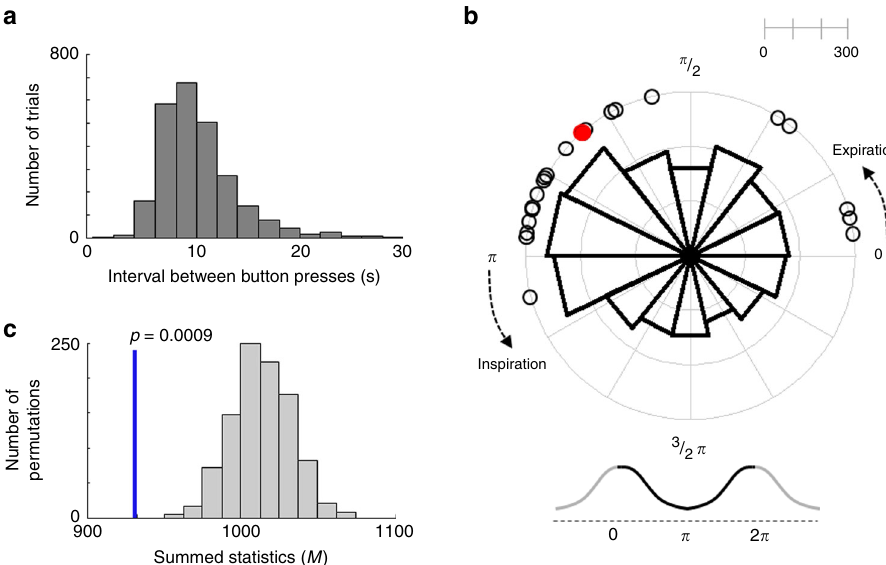
Fig. 1 Coupling between voluntary action and respiratory phase during the Kornhuber task in Experiment 1. a Distribution of intervals between button presses (pooled across 20 participants) showed the typical response distribution. b Distribution of respiration phases with respect to the timing of voluntary action onset. Empty black circles represent each participant ’ s mean respiration phase at button press. Participants initiated voluntary actions more frequently during the late phase of expiration. The polar histogram shows the distribution of all the button presses from 20 participants, which was also concentrated in the late phase of expiration. The red dot indicates the grand-averaged respiration phase at button press. c Histogram of the summed statistics (i.e., minimum number of data points that can be observed in half of the circle; Hodges – Ajne test) obtained from surrogate respiration data. The blue vertical line indicates the summed statistics from original respiration data. The computed test statistics using original data was signi fi cantly smaller than chance-level statistics obtained from phase shifted surrogate respiration data (permutation p = 0.0009), con fi rming the timing of button presses in Experiment 1 is coupled with respiratory